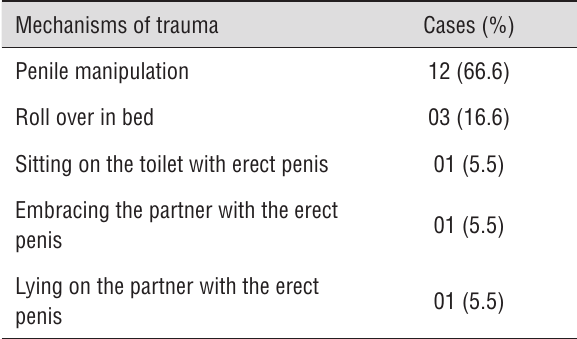
Table 1- Non-sexual etiology of penile fracture.